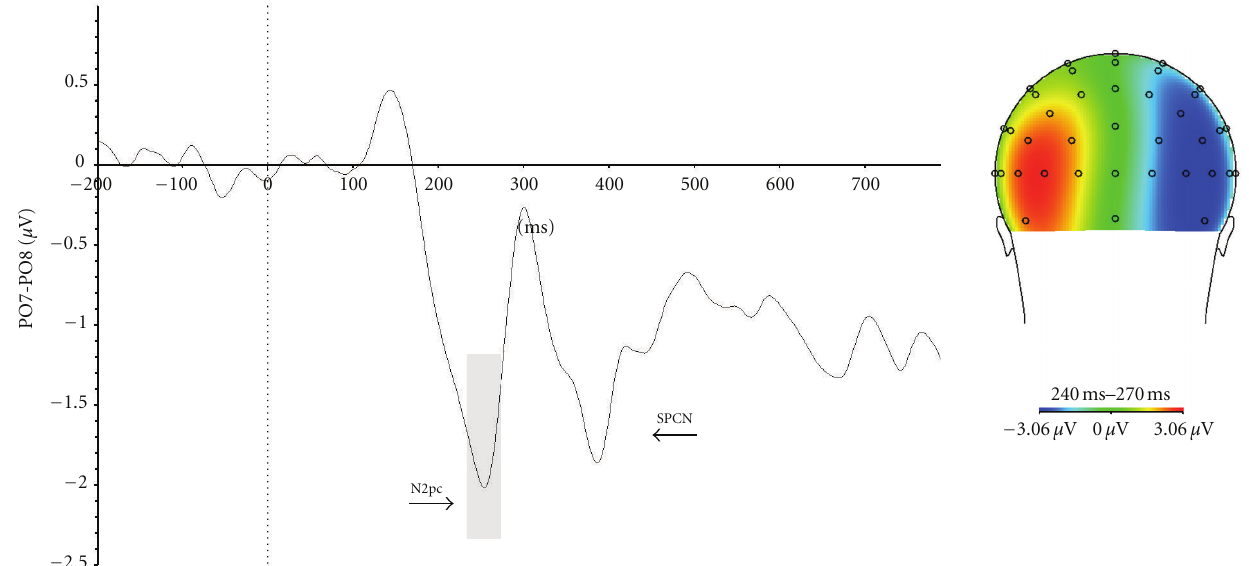
Figure 5: The N2pc component was obtained by subtracting ipsilateral neural activity (recorded over the left hemisphere, PO7, when target stimuli were presented in the left visual field and recorded over the right hemisphere, PO8, when target stimuli were presented in the right visual-field) from Contralateral neural activity (recorded over the left hemisphere, PO7, when stimuli were presented in the right visual field and recorded over the right hemisphere, PO8, when stimuli were presented in the left visual-field). The same subtraction was used to compute the SPCN. To show the scalp distribution of the N2pc, we computed the Grand Average ERP for all trials in which the target was on the left and subtracted from it the Grand Average ERP for all trials in which the target was on the right. As expected if the contralateral response was more negative than the ipsilateral response, the subtraction was positive at left-sided electrodes and negative at right-sided electrodes.